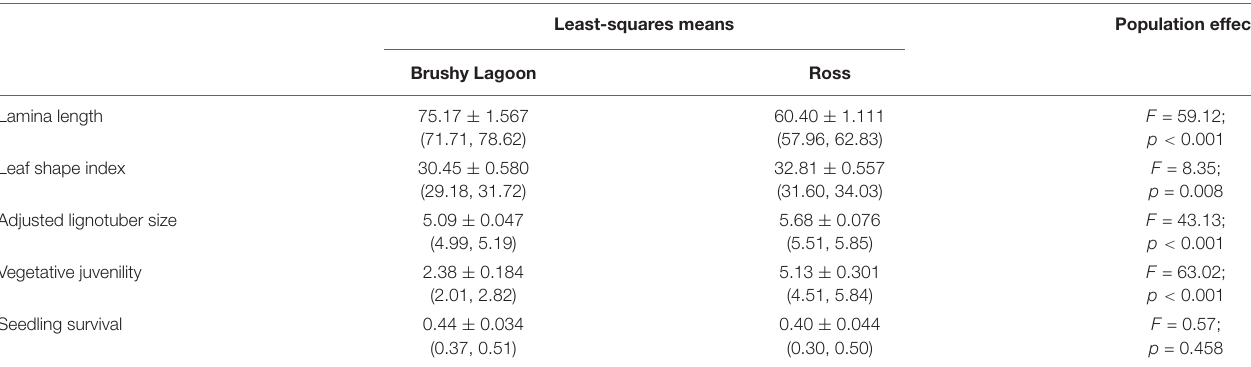
TABLE 2 | Estimates of least-squares means and their standard errors (with 95% confidence intervals within parentheses) for four functional traits (lamina length, leaf shape index, adjusted lignotuber size and vegetative juvenility) and a fitness component (seedling survival) measured in the mesic (Brushy Lagoon) and dry (Ross) populations of E. pauciflora